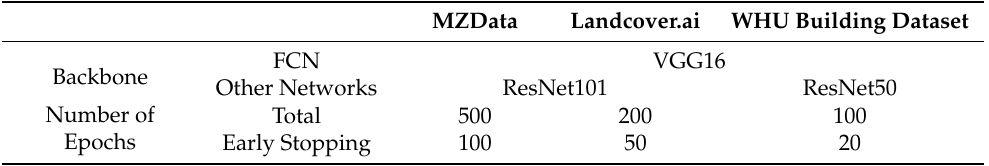
Table 1. Backbone and number of epochs settings for different experimental datasets. MZData Landcover.ai WHU Building Dataset